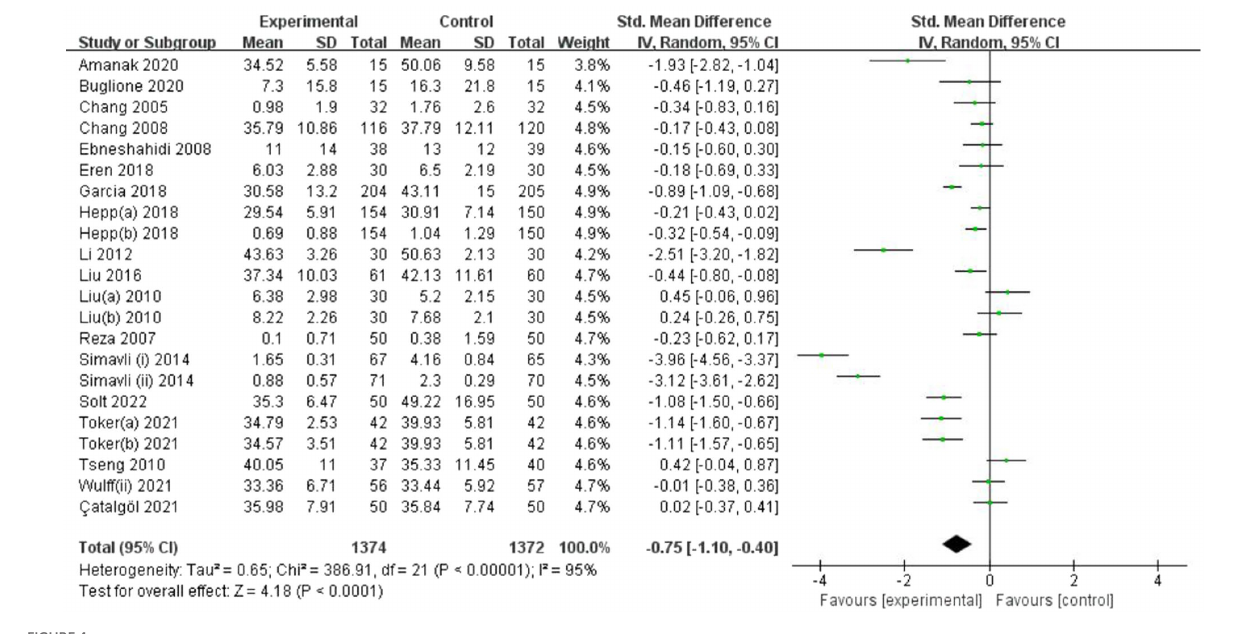
FIGURE 4 Forest plot of posttreatment anxiety outcome for comparing art-based intervention with